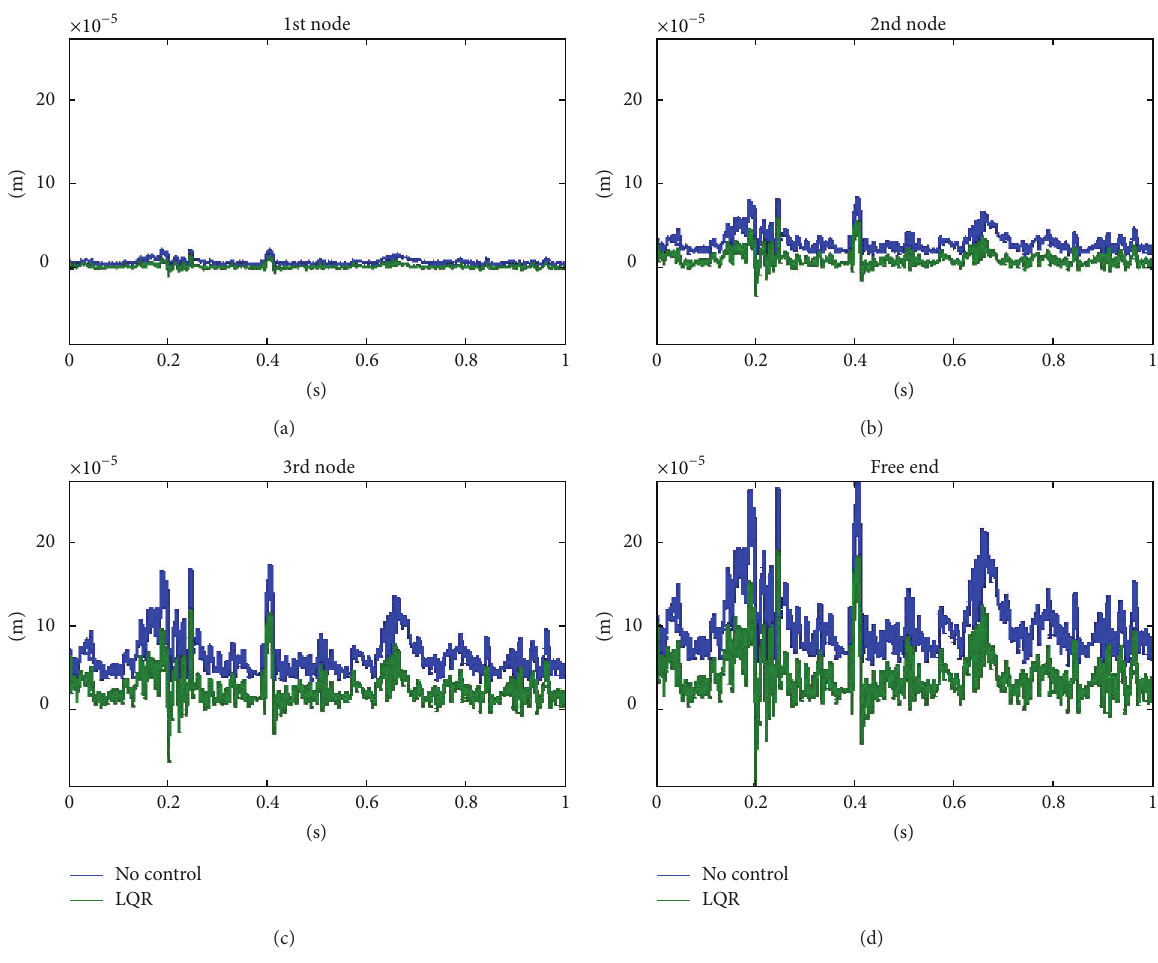
Figure 4: Displacement at all beam nodal points, with and without LQR